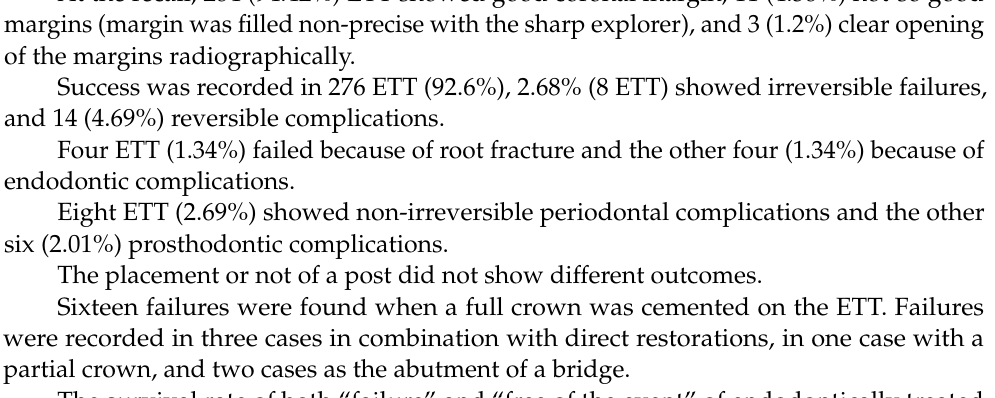
Figure 3. ( a ) A first lower molar with periapical lesion and in need to be retreated. ( b ) The molar immediately after being endodontically treated. Four canals (one in a radix entomolaris) were detected and treated. ( c ) The molar after 4 years. The good health of the periapical areas can be noted. The crown was restored with an adhesive esthetic onlay.